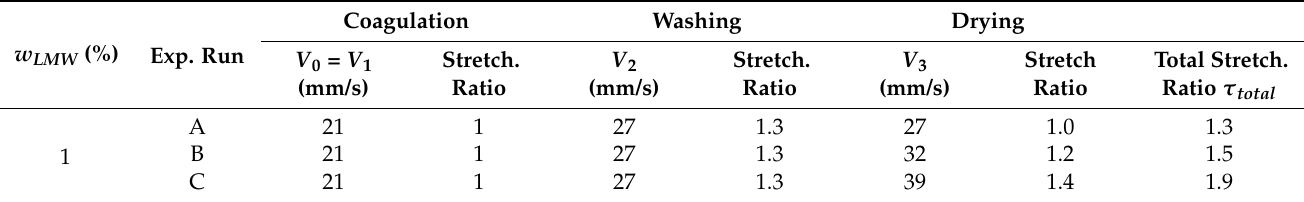
Figure 10. Wet gel spinning set up used to create fibers containing low and high-molecular weight chitosans, consisting of a pressurized syringe with conic needle (Nordson ® dispenser, Saint-Thibault-des-Vignes, France), a coagulation bath (Sodium Hydroxyde solution), 3 motorized stretching rollers (in green), which rotate at an adjustable speed to control the stretching rates, 8 guiding rollers (circles in blue/black), guiding the fiber into washing and drying zones with different stretching rates, and a final take-up spool (last black circle) where the fiber is stored once it has been stretched, washed and dried. Table 5. Example of spinning stretching ratios used in experiment runs for samples containing w LMW = 1%. The 3 stretching rollers attached to the motor have a controllable speed ( V 1 , V 2 , and V 3 ) by adjusting the voltage supply (Figure 10). Their speeds determine the stretching ratio at each of the sections of the spinning process: stretching ratio during coagulation step V 1 / V 0 , stretching ratio during the wash step V 2 / V 1 , and stretching ratio during the drying step V 3 / V 2 . These 3 stretching ratios were used to obtain the total stretching ratio τ total = V 3 / V 0 . V 1 was set to induce neither stretching nor accumulation during the coagulation: V 1 = V 0 . Low, medium, and high total stretching ratios τ total of 1.3, 1.5, and 1.9 were considered in the